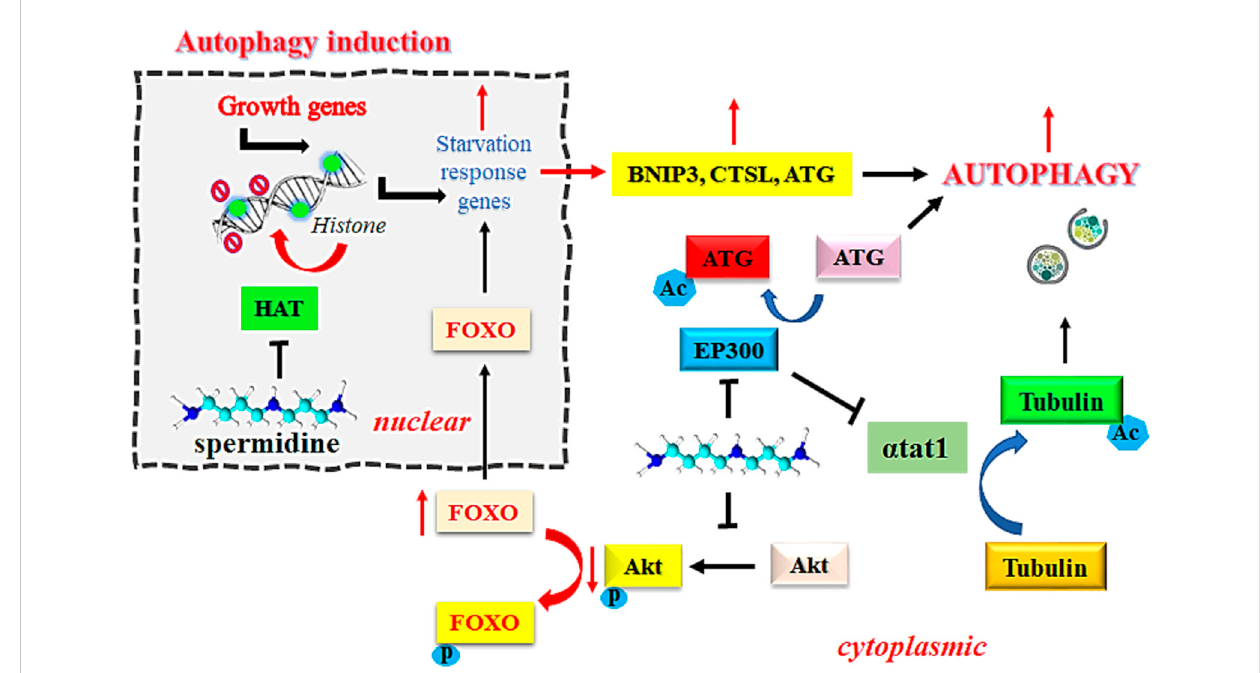
FIGURE 1 Mechanism of spermidine-induced autophagy. Abbreviations: FOXO: Fork-head transcription factors of the O class; Akt, Ak strain transforming; BNIP3, BCL2/adenovirus E1B 19 kDa protein-interacting protein 3; Ac, acylated; P, phosphorylated; HAT, histone acetyltransferase; EP300, E1A- associated protein p300; α tat1, α -tubulin acetyltransferase; CTSL, cathepsin L; ATG, autophagy related